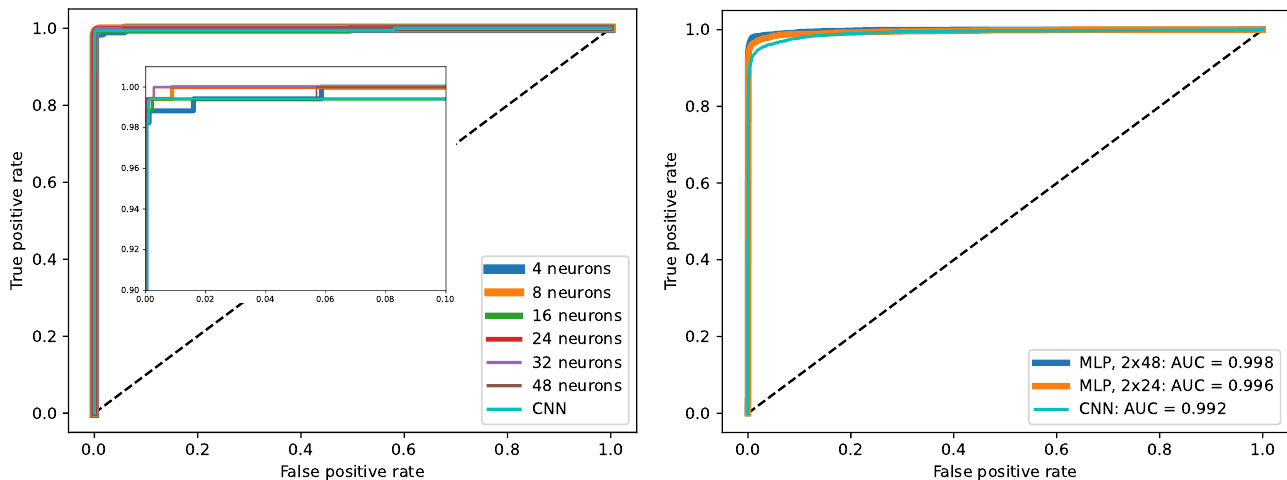
Figure 10. ROC curves for the training ( left ) and testing ( right ) stages for the CNN and MLPs with 2 hidden layers and different number of nodes in each layer.